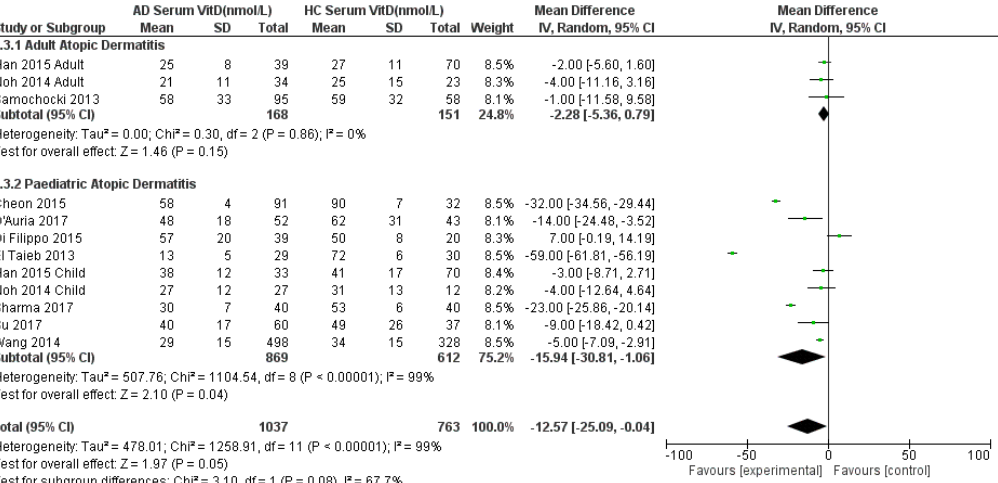
11 of 19 Figure 2. Forest Plot for meta-analysis of serum 25(OH)D levels in atopic dermatitis population compared with healthy controls (nmol/L). References: Cheon 2015 [27]. D’Auria 2017 [28]. Di Filippo 2015 [29]. El Taeib 2013 [30]. Han 2015 [31]. Hata 2014 [35]. Noh 2014 [32]. Samochocki 2013 [33]. Sharma 2017 [25]. Su 2017 [34]. Wang 2014 [26] . A sensitivity analysis was performed (Table S3). The effect size stayed very stable when studies were removed in turn, except for being lower (around a 9 nmol/L group difference) when El Taieb et al. (2013) [30] was removed. Also, the removal of Cheon et al. (2015) [27], Wang et al. (2014) [26], and Sharma et al. (2017) [25] rendered the effect size not statistically significant. A further sensitivity analysis was done specifically for studies from common regions and ethnicities, including 3 studies from South Korea and two studies from Italy (Table S4). The effect size was not statistically significant when including only the Korean studies, although the magnitude of the effect was similar to when all studies were included (25(OH)D status was still around 14 nmol/L lower in the AD than in the non-AD group). The inclusion of only the Italian studies still gave a statistically significant result, with a similar effect size to that for all studies (16 nmol/L group difference). A sub-analysis by age was also conducted, separating the purely adult AD and paediatric AD populations with their same age HC (Figure 3). The sub-analysis for the paediatric population showed a statistically significantly lower serum 25(OH)D in AD children by 16 nmol/L compared to HC: −16 (95% CI −31 to −1, p = 0.05, I ² = 99%). Considerable heterogeneity was noted ( I 2 = 99%) so a